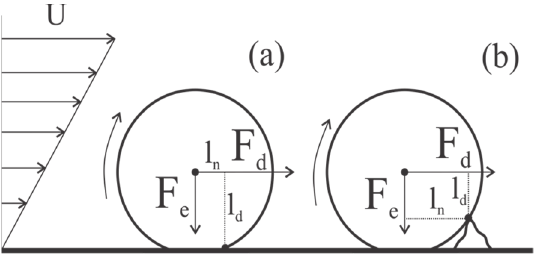
Figure 2. Schematic of fines detachment in shear Hele-Shaw flow under the action of capillary, drag, lift, and electrostatic forces: ( a ) lever arms are determined by the contact grain-particle area; ( b ) the lever arms for fine rolling around the rock-surface asperity.